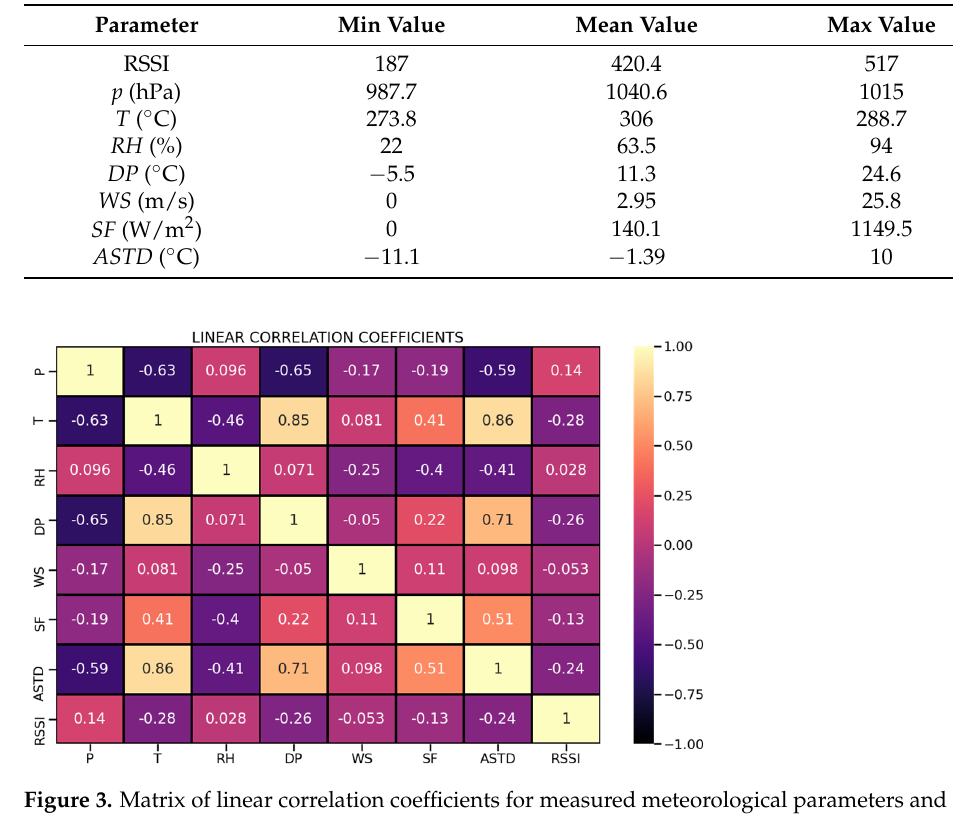
Figure 2. Flow chart diagram for the ML-based methodology for FSO system RSSI modeling.